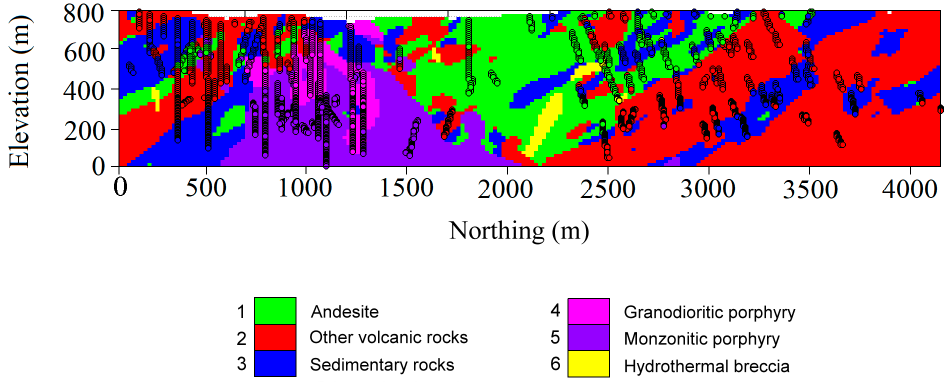
Figure 5. Interpreted rock type model in a cross-section under study. Sample drill hole data have been superimposed. Local coordinates are used to preserve the confidentiality of the